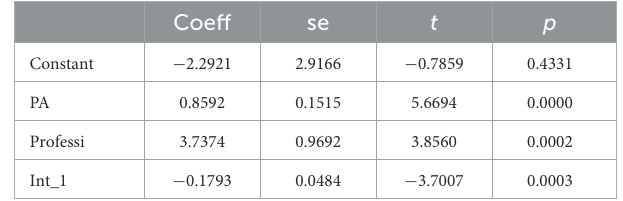
TABLE 13 Deep Acting and Personal Accomplishment, with professional growth as the